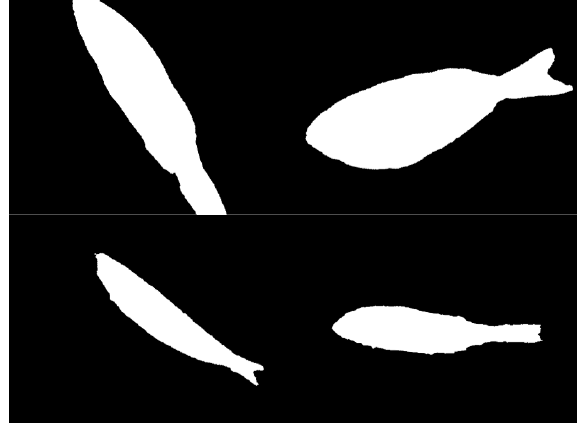
Figure 13. The segmentation results of SegNet.